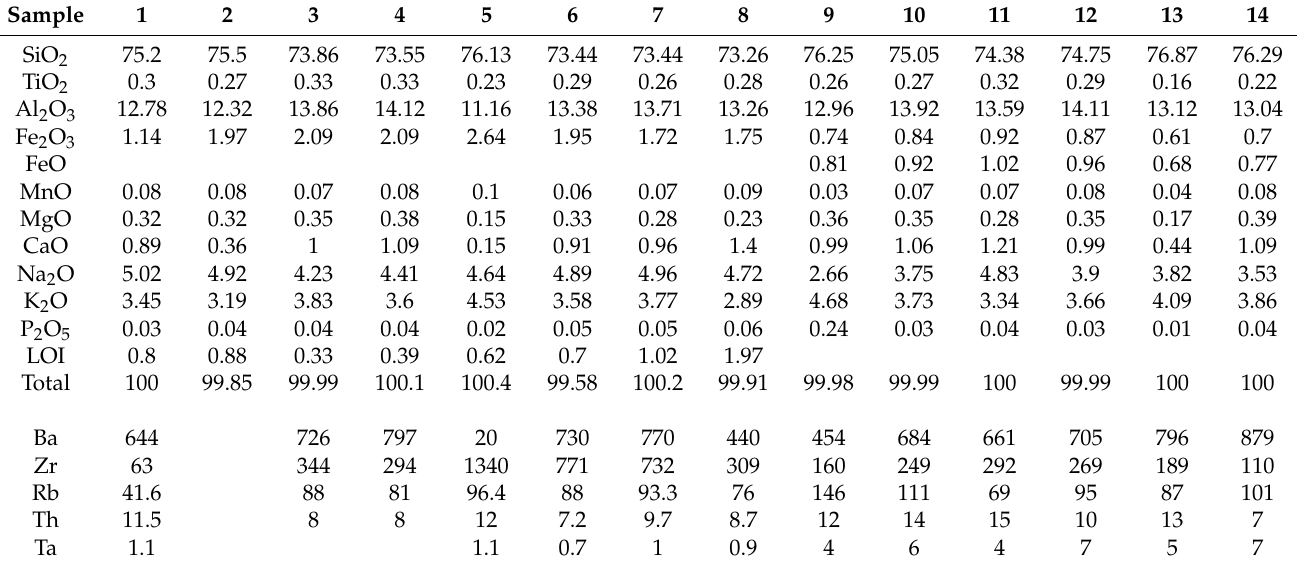
Table 1. Whole rock major (wt%), trace and rare-earth element (ppm) data of the Wadhrai